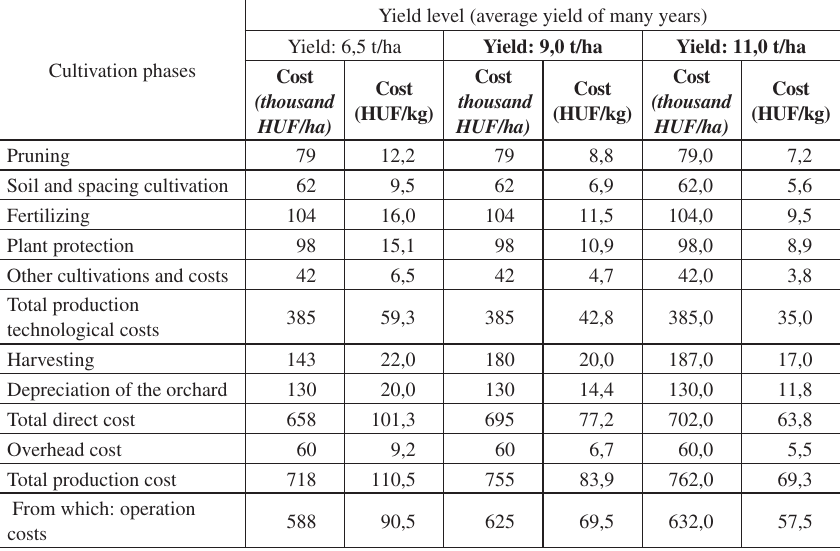
Table 2: The Production Cost of the Elderberry Orchard Cultivated on a Good Standard Relating to the Whole Productive Years, in Case of Different Yield Levels Yield level (average yield of many years) Yield: 6,5 t/ha Yield: 9,0 t/ha Yield: 11,0 Cultivation phases